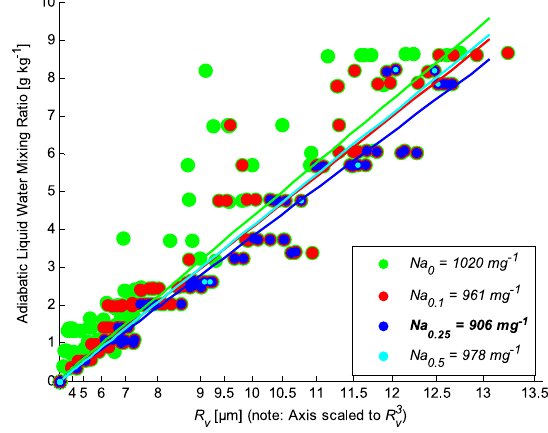
Fig. 2. The droplet mean volume radius ( R v ) vs. the adiabatic liquid water mixing ratio (LWC a ) for different threshold adiabatic frac- tions. The 1Hz measurements were taken during the CAIPEEX-1 (Cloud-Aerosol Interaction and Precipitation Enhancement Exper- iment, phase 1; Kulkarni et al., 2009) program over central India on 25 August 2009 (flight 20090825) at elevations between 500 and 5000m.a.s.l. The green, red, blue and cyan colors denote thresh- old adiabatic fractions of 0, 0.1, 0.25 and 0.5, respectively. The R v and AF data are based on the Droplet Measurement Technologies (DMT) Cloud Droplet Probe (CDP) measurements while the num- ber of activated CCN ( N a ) is derived from the slope of the linear best fit (Eq. 1). It can be seen that the AF filter selected does not affect the derived N a remarkably. Using N a as N a looks like a 0 . 25 init reasonable compromise between having enough data points to rep- resent the entire profile, and having a large LWC a range for deriving a representative N a for the entire init